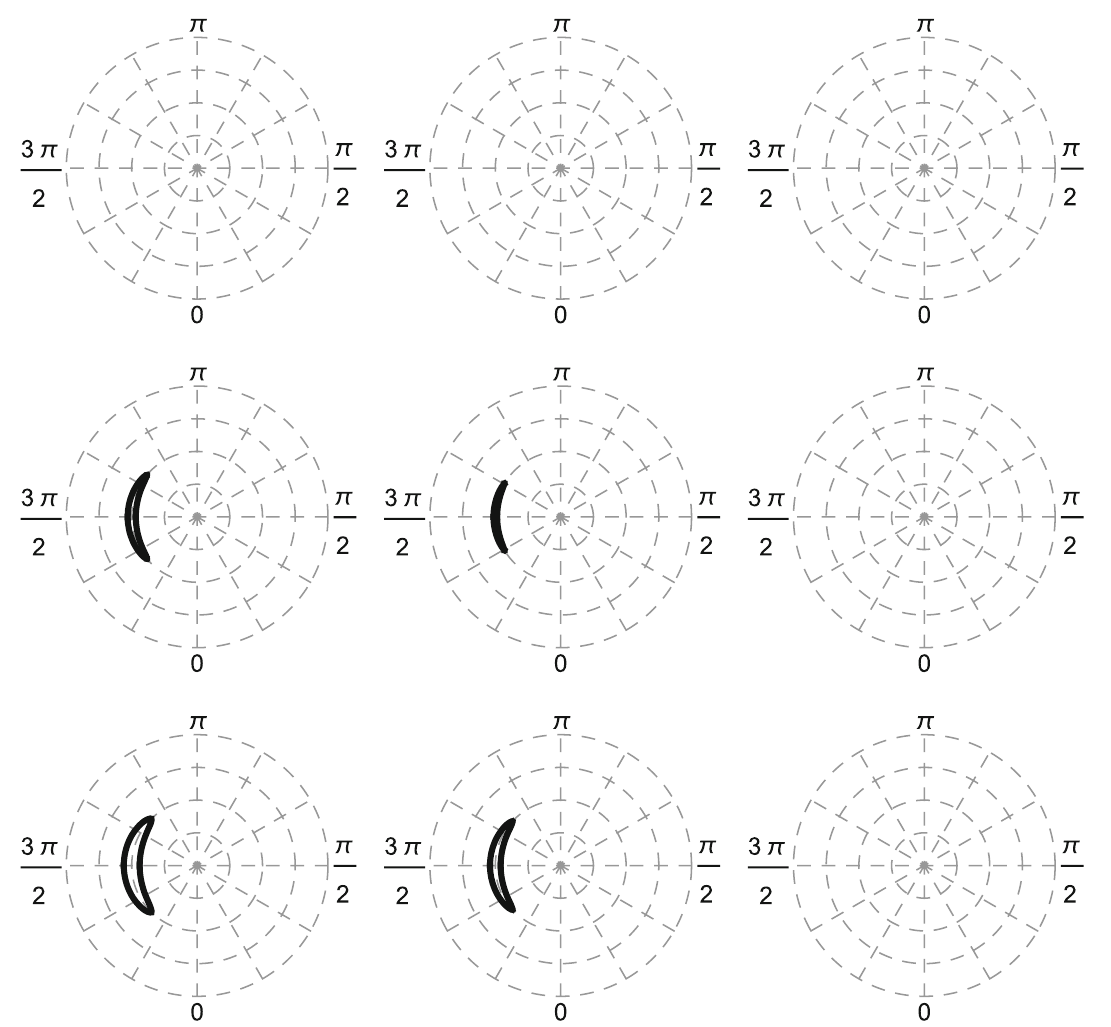
Fig. 13 Escape cones for objects with compactness R / M = 3 . 2 for several values of θ and j . The first column is for θ = π/ 2, the second column is for θ = π/ 4 and the last column is for θ = 1 / 100. The first row is for j = 0 . 1, the second row is for j = 0 . 4 and the last row is for j = 0 .